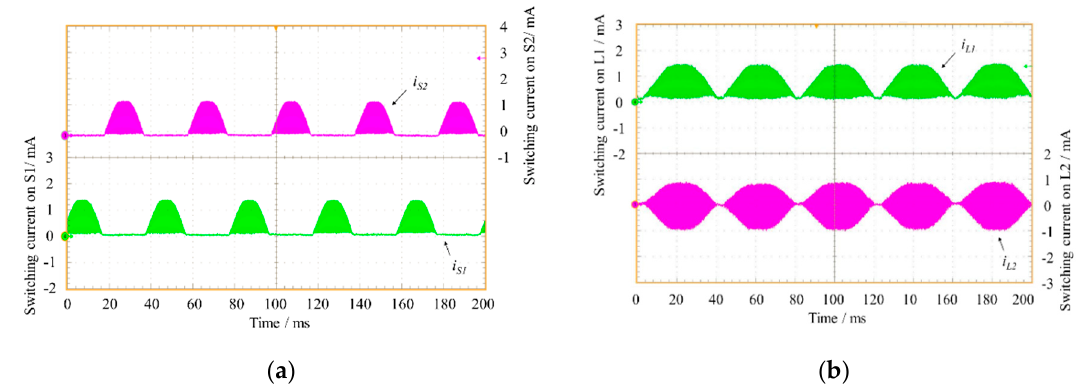
Figure 12. ( a ) Plots of switching currents i S 1 (in green) and i S 2 (in magenta); ( b ) plots of switching currents i L 1 (in green) and i L 2 (in magenta).